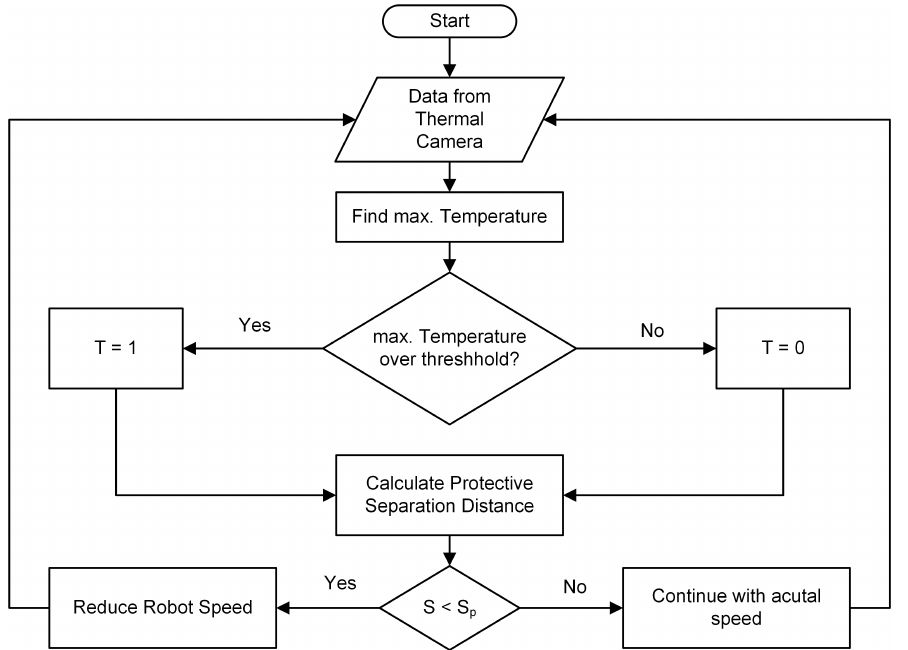
Figure 7. Flow chart of temperature decision for speed